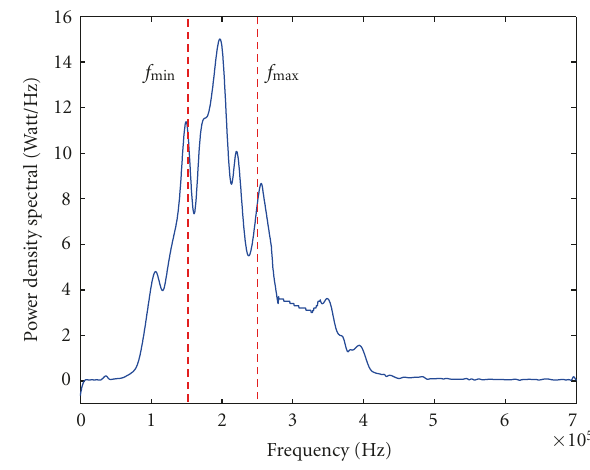
Figure 6: Power spectral density of the signal received on fifth sen-